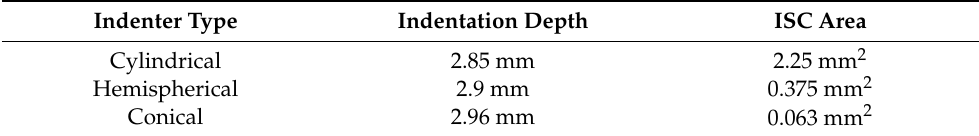
Figure 6. Comparison of mechanical response for various indenters: ( a ) force–global strain curve for each indenter; ( b ) LIB deformed shape by indenters. Table 2. Mechanical response of a LIB cell under various indenters.